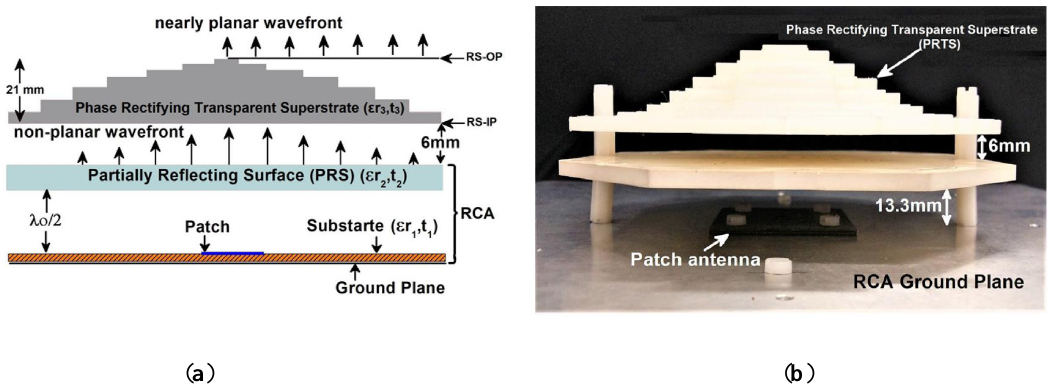
Figure 10. Configuration of a RCA with an aperture phase distribution compensation: ( a ) Schematic; ( b ) Fabricated prototype [82].